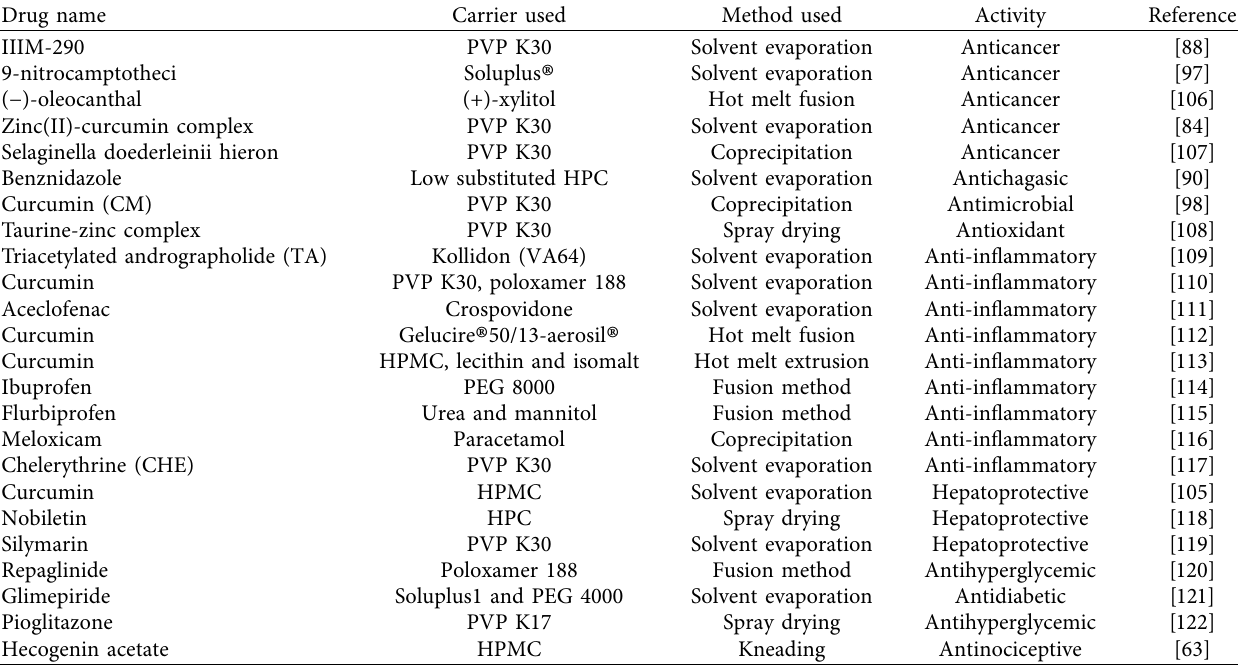
Table 10: In vivo studies with solid